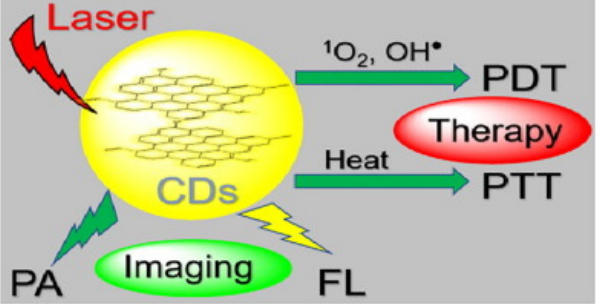
Figure 15. Lysosome targetable C-DOTS which can simultaneously generate 1 O 2 , OH • , and heat under 635 nm laser irradiation. Reproduced from Ref. [123]. Copyright 2020